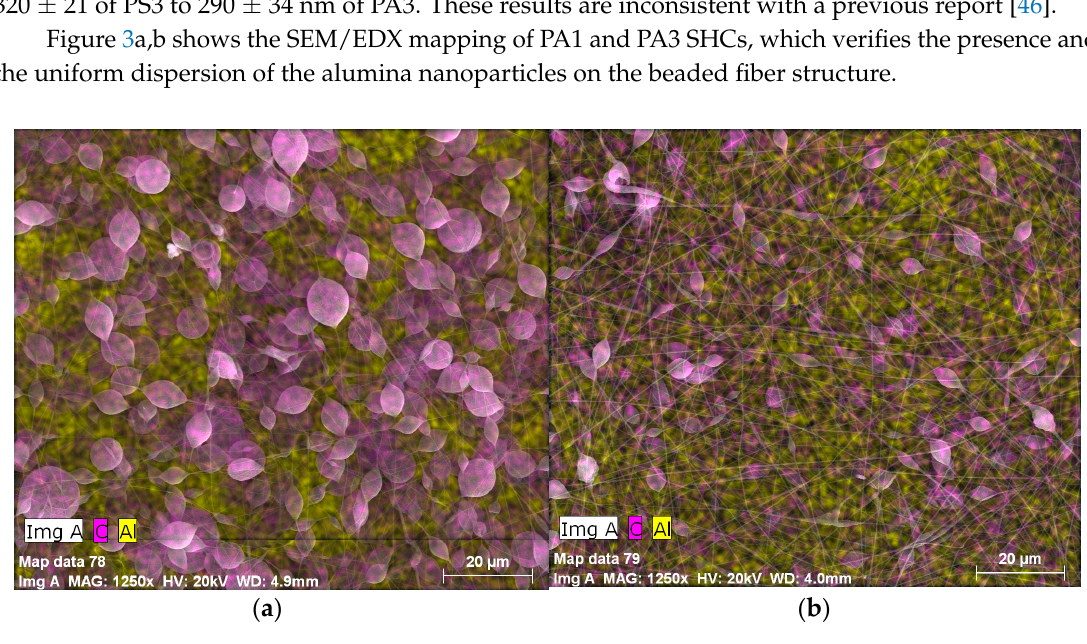
Table 3. WCA and CAH of the prepared PS and PS/Al 2 O 3 nanocomposite coatings.